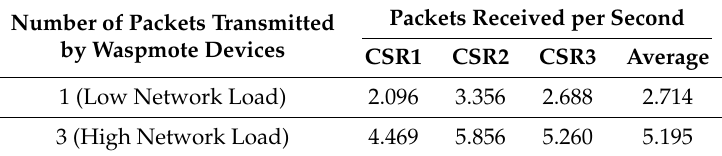
Table 12. Packets per second received by CSR devices when they retransmit each packet once. Waspmote devices configured as Individual Mesh